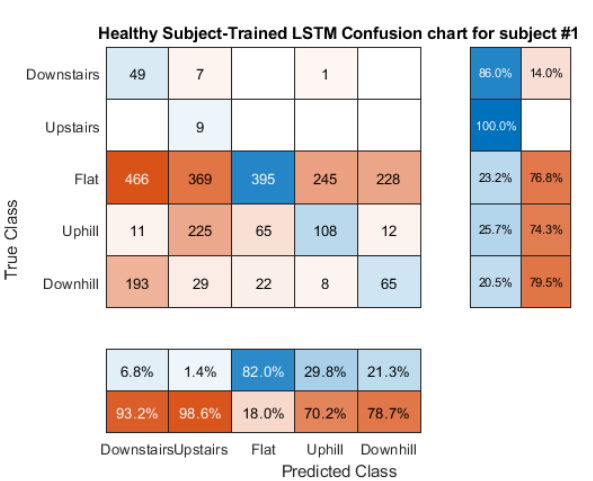
Figure A15. Long Short-Term Memory Network Confusion Chart for ILLA participant A1 as trained by healthy